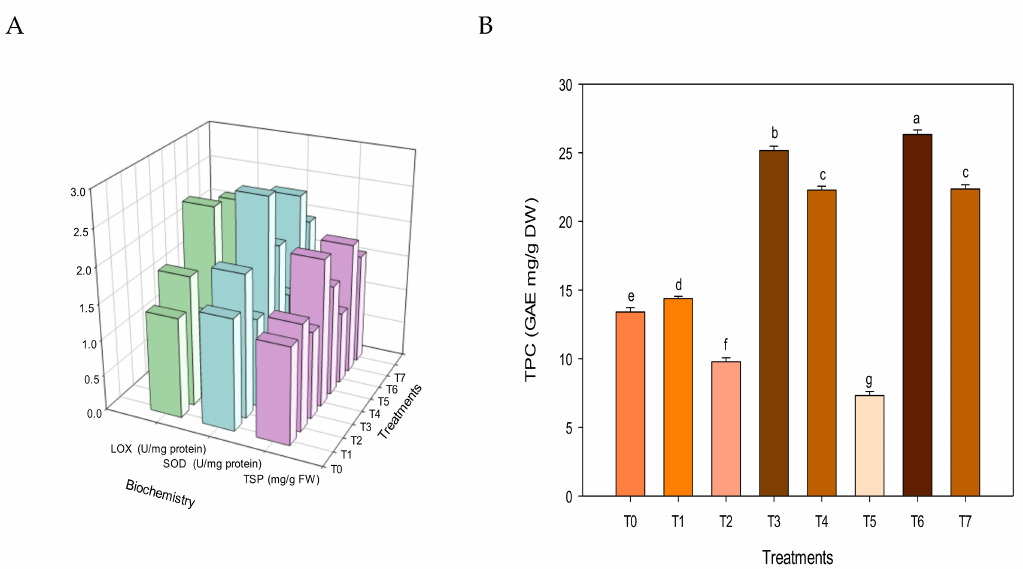
Figure 5. Effect of SWE on mitigating salt stress effects on plant functional metabolites ( A ) TSP (mg/mg FW); SOD and LOX ( µ g/mg protein); ( B ) Total phenol contents (GAE mg/g DW). Mean ( ± SEM) of 5 replicates. Within each time point, the same letter indicates no significant difference ( p ≤ 0.05) in a Tukey’s test. (T0—Control, T1—NC, T2—NC + S150 mM, T3—PC, T4—PC + S150 mM, T5—S150 mM, T6—SWE 80%, T7—T5 + T6).